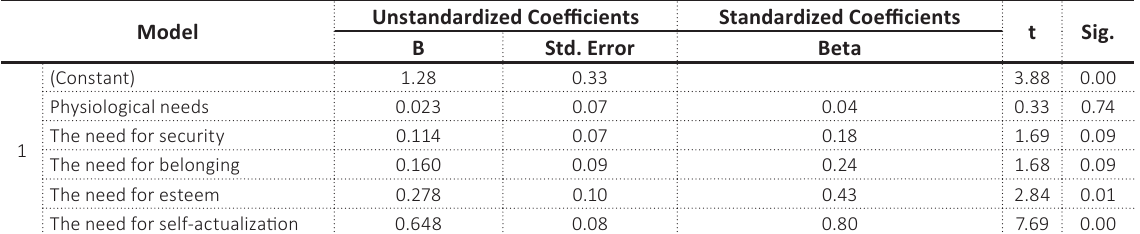
Table 3. ANOVA for the influence of Maslow’s hierarchy of needs on mumpreneurs’ intentions